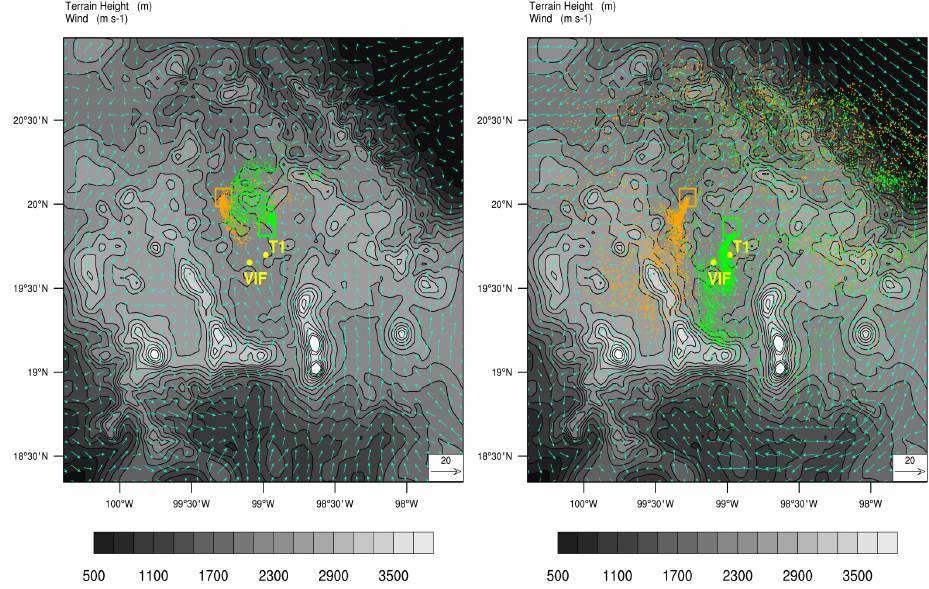
Figure 5. Emissions from Tizayuca (green) are feasible to merge with emissions from TIC (orange). Left panel shows the forward dispersion of both plumes on 22 March at 22:00LST. Right panel corresponds when northerly flow transports the plumes back to the basin, highlighting contribution from the northeast on 24 March at 01:00LST.